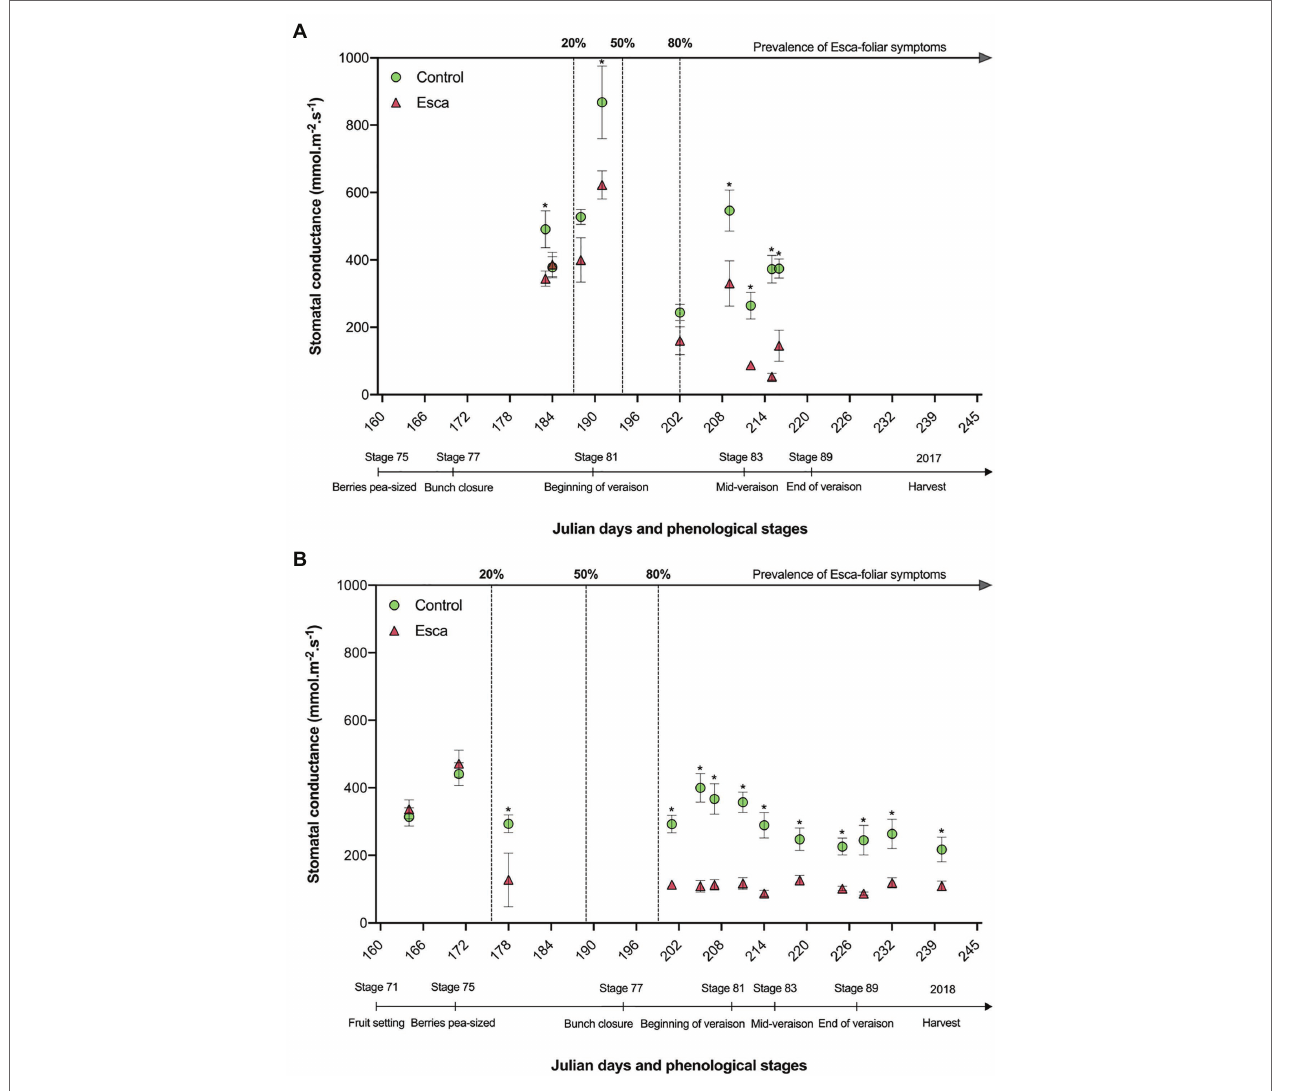
FIGURE 5 | Evolution of stomatal conductance (g s ) in asymptomatic and symptomatic Cabernet Sauvignon grapevines recorded in 2017 (A) , and in 2018 (B) . Key-growing phenological stages and the prevalence of Esca appearance are also represented below and above the horizonal axes, respectively. Error bars represent SE, and stars above g s values at a given date indicate a significant difference between asymptomatic and symptomatic grapevines at p <